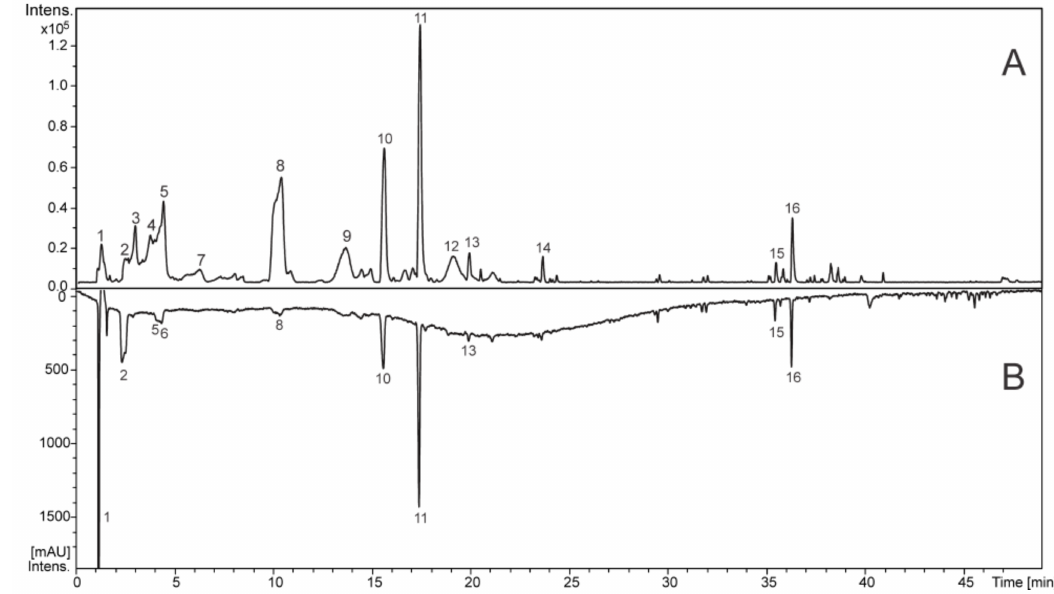
Figure 1. Total ion chromatogram in the negative ion mode ( A ) and chromatogram at wavelengths of